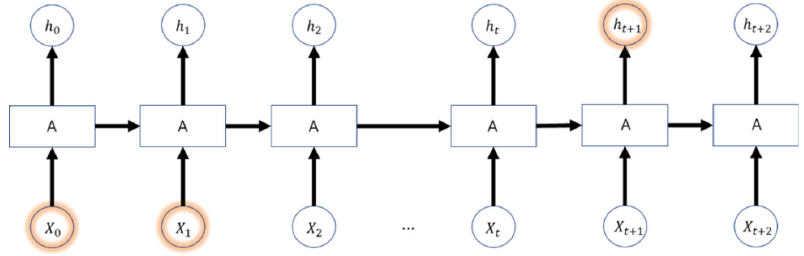
Fig. 6. Long-term memory of RNN